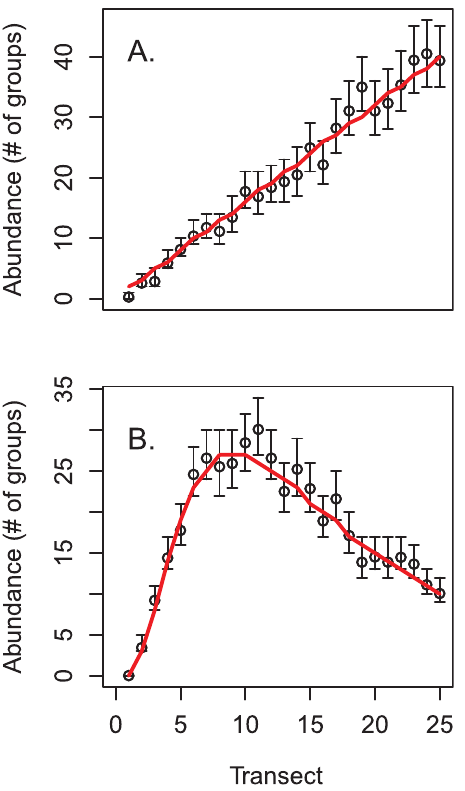
Figure 2. True and estimated population size for simulated data. True abundance is indicated in red, with posterior means and estimated 95% credible intervals for abundance indicated by circles and brackets, respectively. Panel (A) gives results for the simulation with linearly increasing abundance, while panel (B) gives results for the simulation with a quadratic relationship between abundance and a habitat covariate.